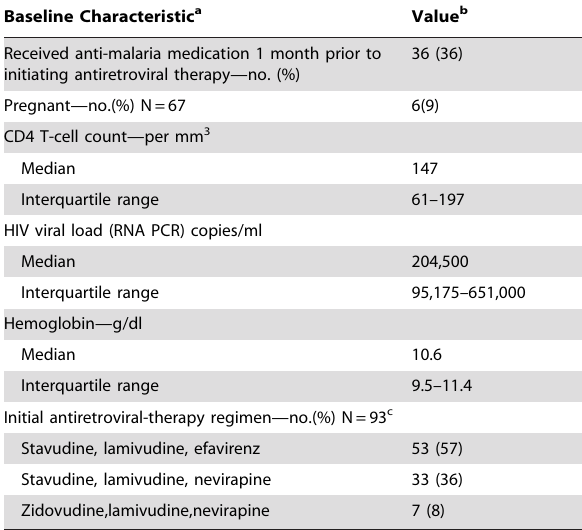
Baseline Characteristic a